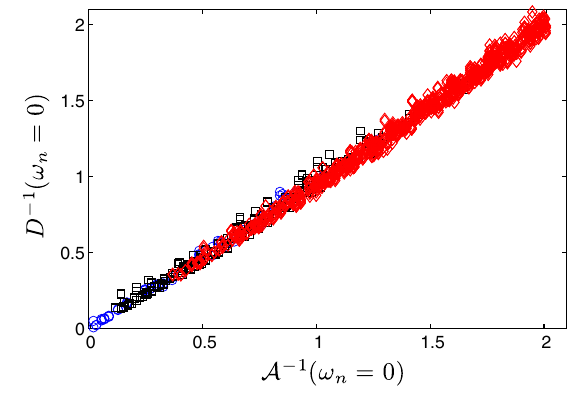
0 ) n ¼ ffiffiffi p 2 (568 data